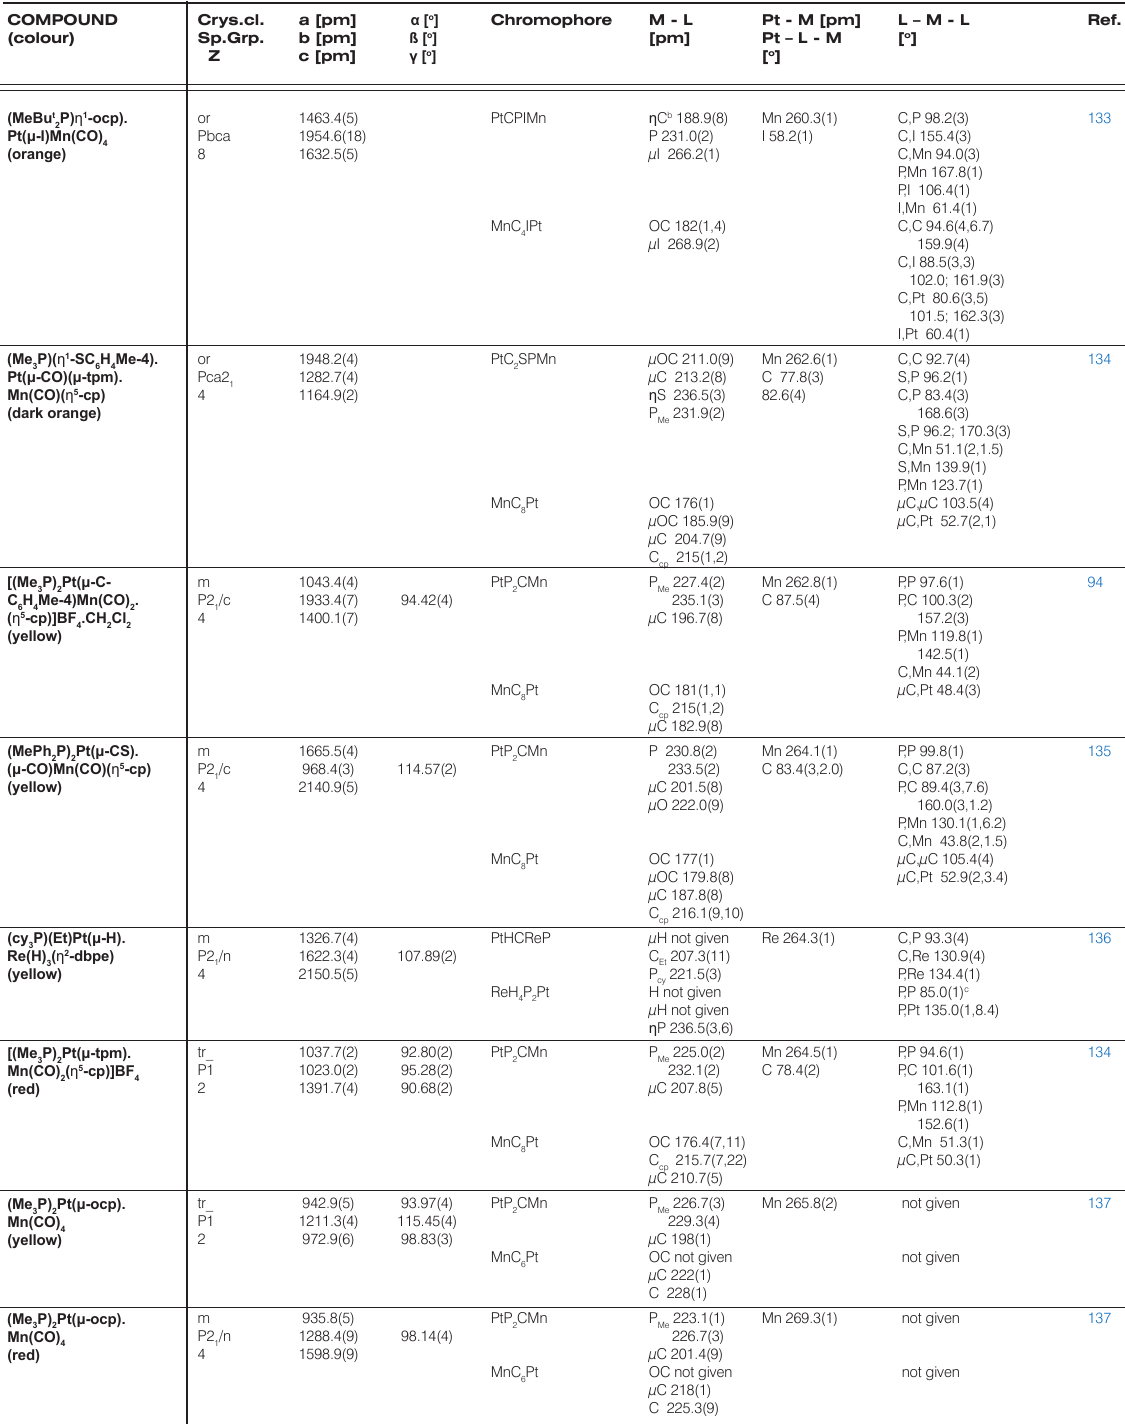
Table 4. Heterobinuclear Platinum Compounds with Pt-M Bond (M = Mn or Re) a